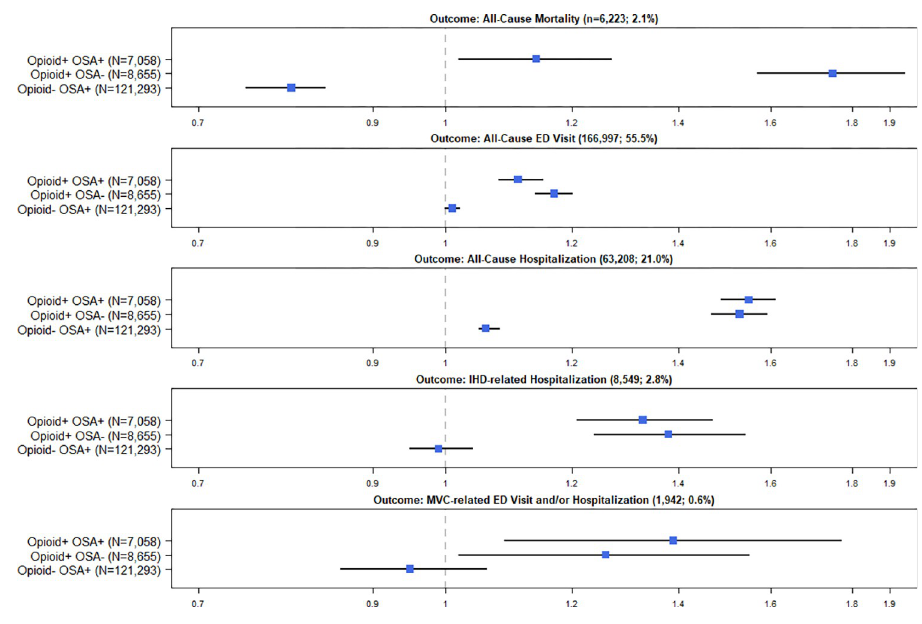
Fig 2. The effect of the presence of opioid use (Opioid +) and at least a 50% probability of moderate to severe obstructive sleep apnea (OSA+) on outcomes compared to a reference group (Opioid-OSA-) controlling for confounders. Effects expressed as adjusted hazard ratios and 95% confidence